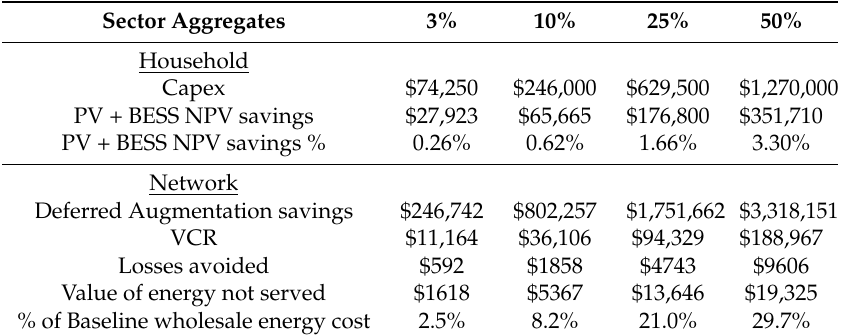
Table 12. Twenty-five year financial results against baseline of retail power